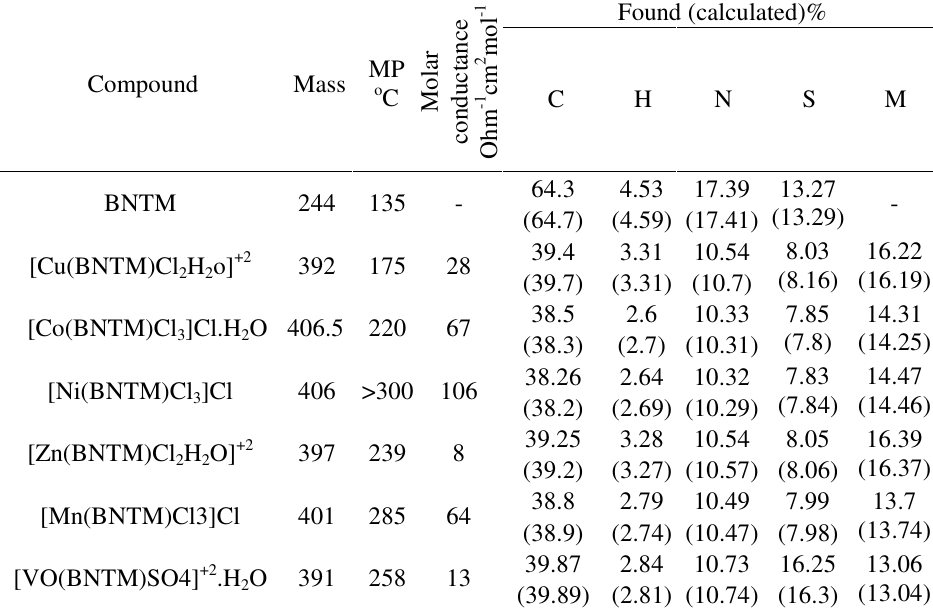
Table 1. Physical properties and analytical data of Schiff base and its metal complexes